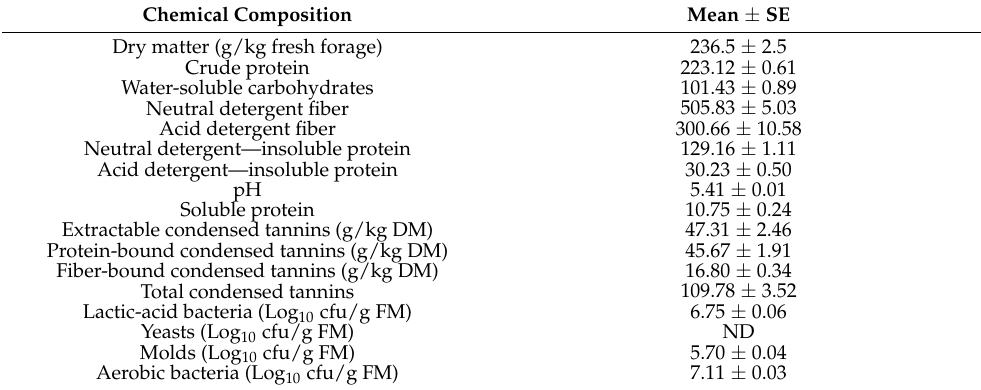
Table 1. Chemical compositions of wilted whole-plant sainfoin harvested at early flower stage for silage 1